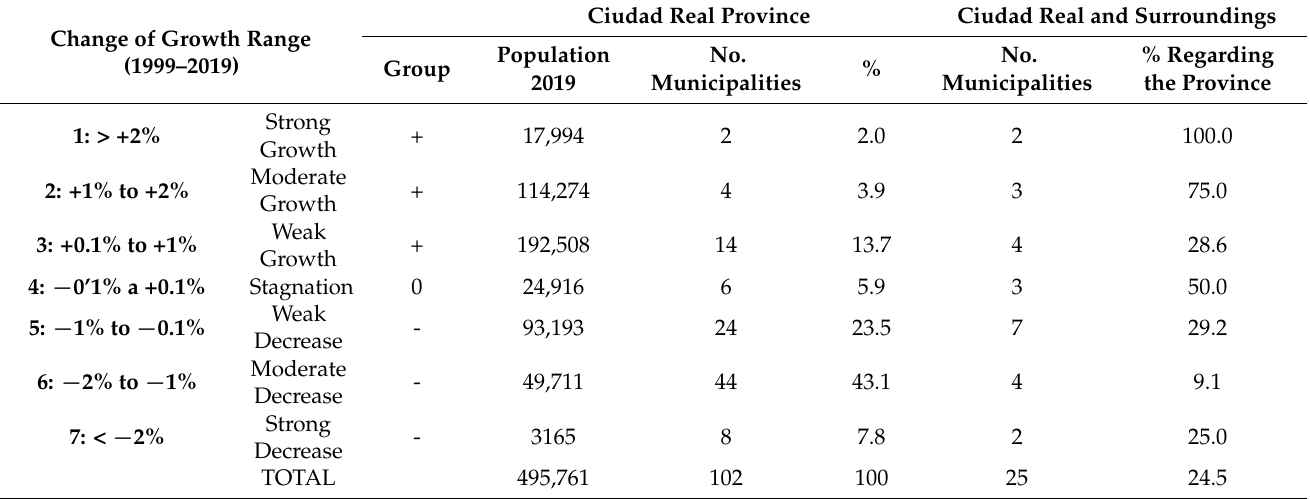
Table 2. Typology of Growth Rate in the province with respect to Ciudad Real and surroundings, Source: Compilation based on ID2CR project: Depopulation and depopulation in Ciudad Real